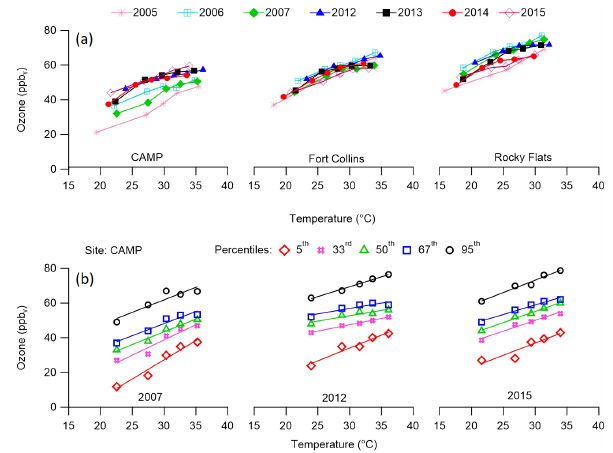
Figure 9. Slopes from one-sided linear regression of O 3 versus temperature (i.e., the temperature dependence of O 3 ) . Hourly O 3 (10:00–16:00LT) is binned by hourly temperature, with bins con- taining 51–110 points for O 3 and temperature depending on data availability at a site. The temperature bins typically contained 100– 110 data points (>90% of temperature bins for all sites in all avail- able years). The slopes of O 3 versus temperature for the 5th, 50th, and 95th percentiles for the O 3 –temperature bins are shown. Data are shown for CAMP (black squares), Welby (grey solid circles), Carriage (blue open triangles), Fort Collins (green solid squares), Greeley (teal Xs), and Rocky Flats (magenta open diamonds). Shaded years correspond to Colorado summers with moderate to severe drought conditions. Error bars are ± 95% confidence inter- val of the slopes. Faint grey line across the 50th percentile is the average slope bounded by the 95% confidence interval for years excluding 2008, 2011, and